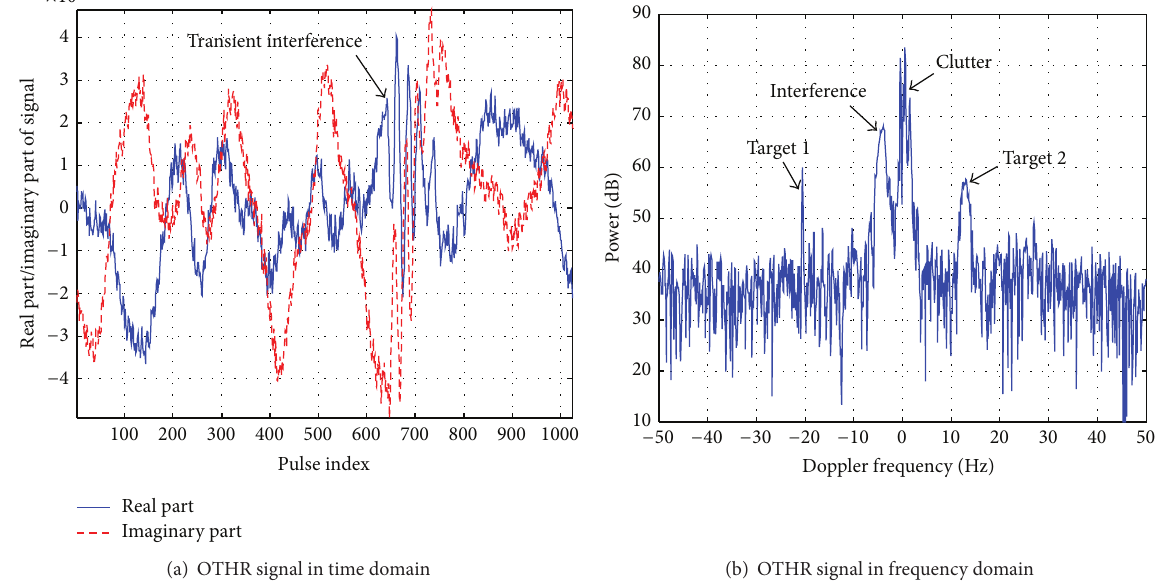
Figure 3: The raw echoed data of